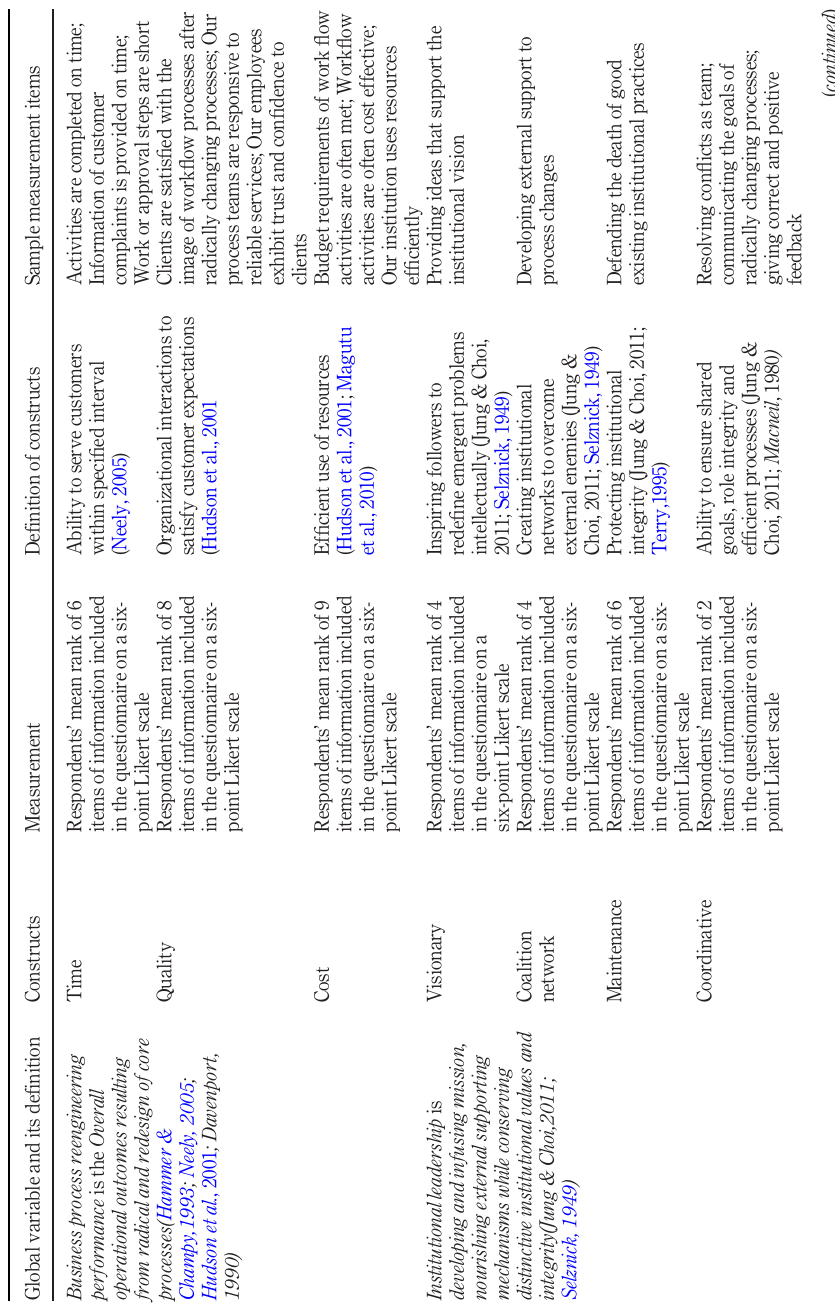
Table AI. Operationalization and measurement of study